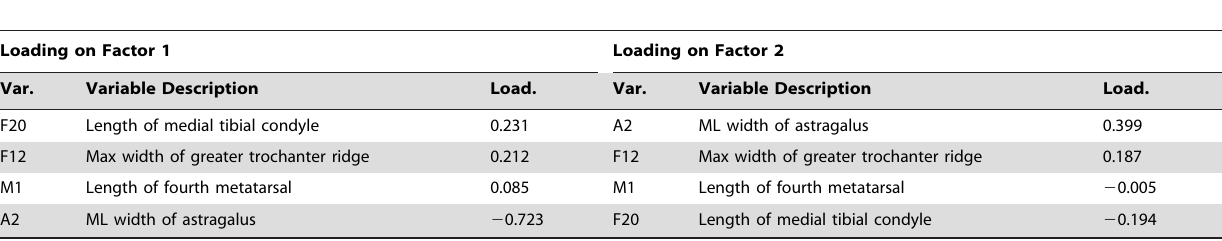
Table 3. Coefficient loadings for Discriminant Analysis: all hind limb bones (sthenurines and extant macropodines only).